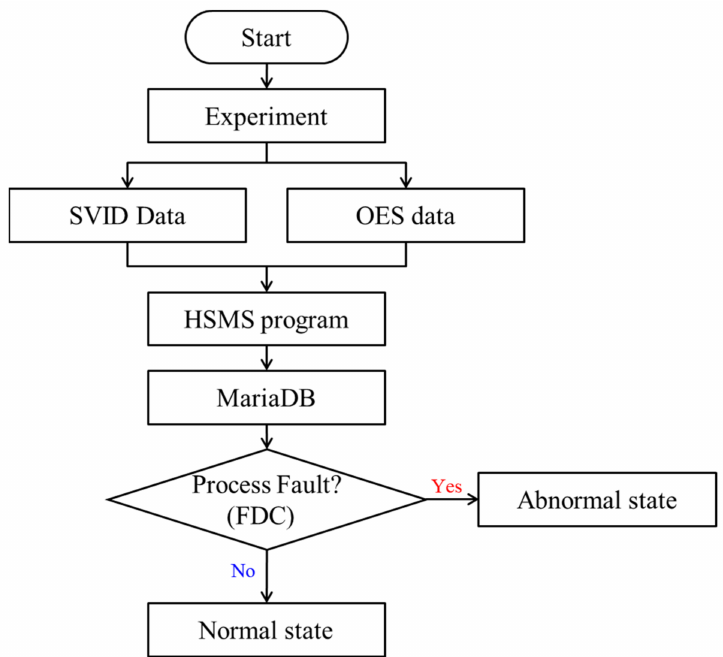
Figure 3. Data monitoring and acquisition system. State variable identification (SVID), High- speed SECS Message Service (HSMS), optical emission spectroscopy (OES), fault detection and classification (FDC).